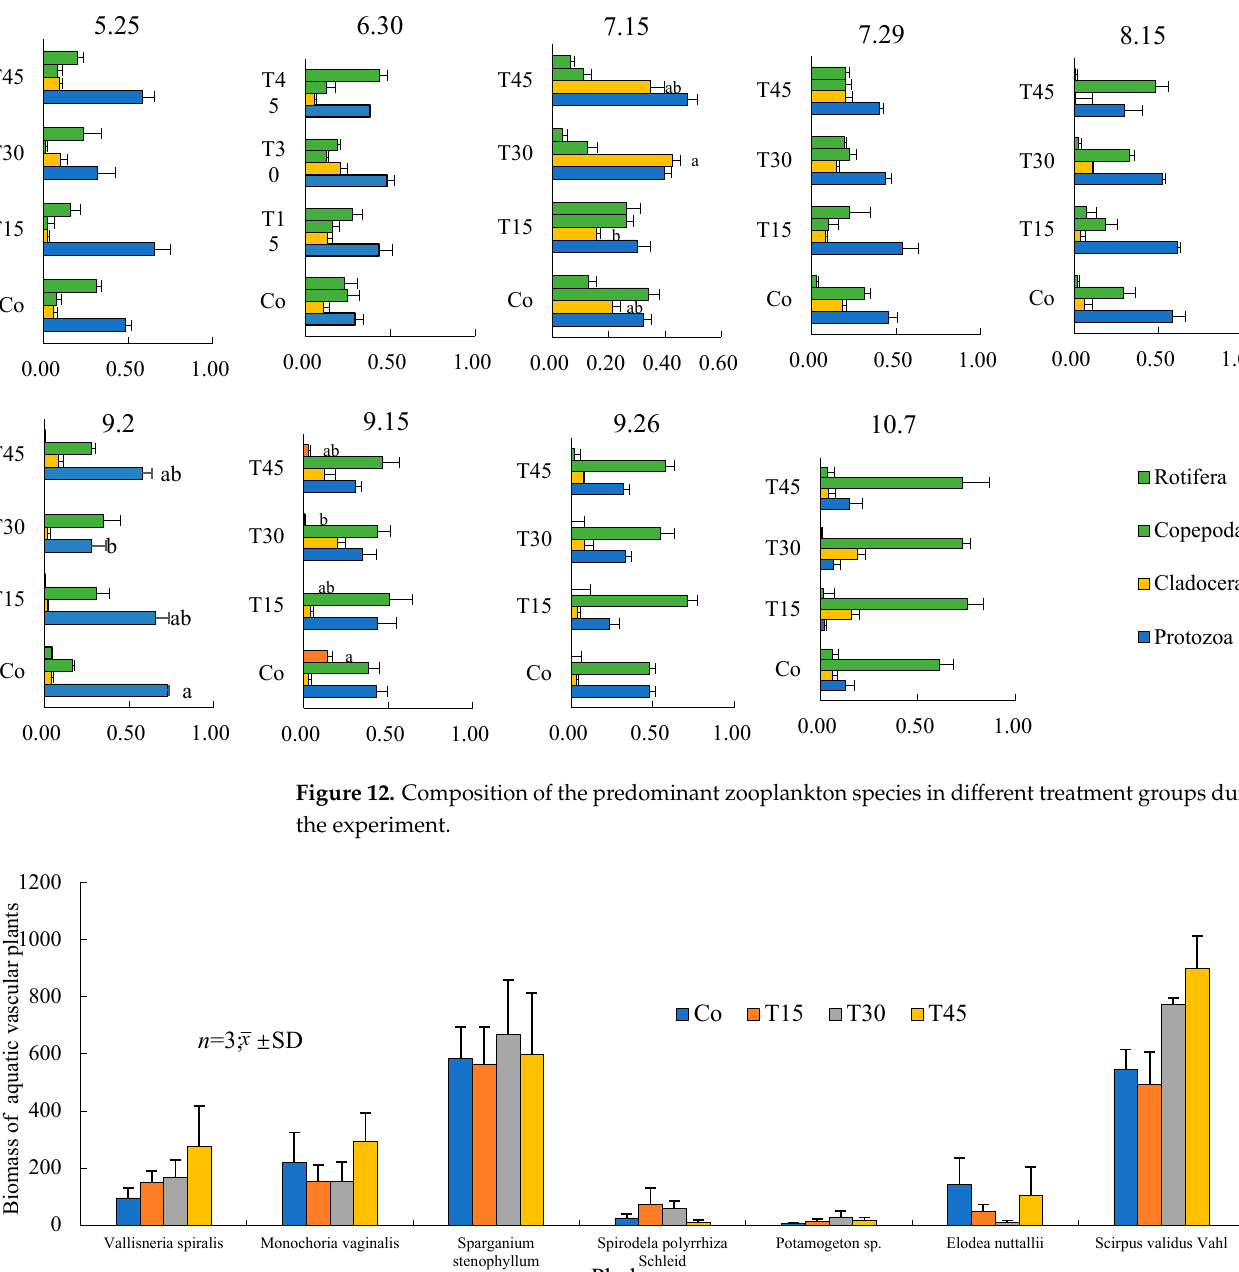
Figure 13. Species and biomass of aquatic vascular plants in different treatment groups during the experiment.